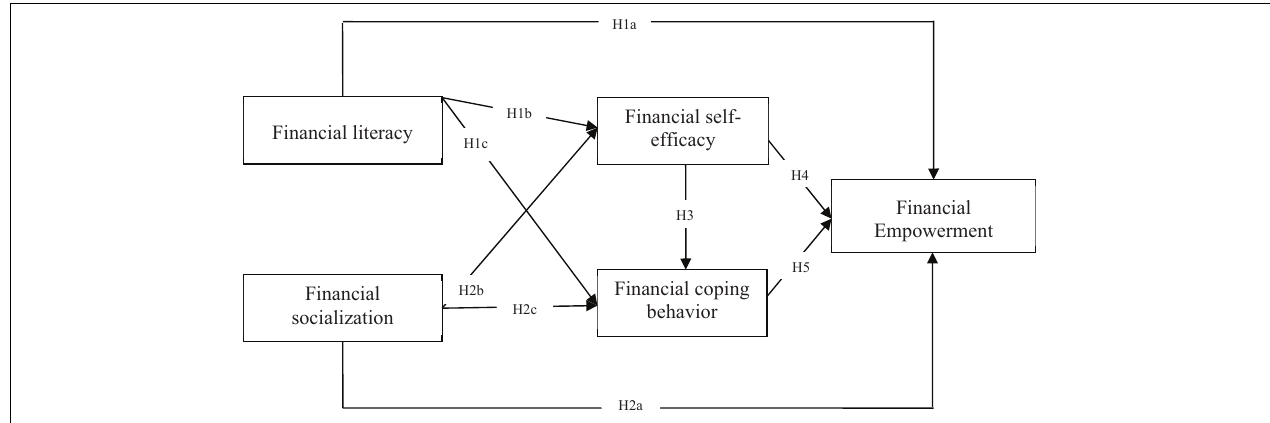
FIGURE 1 | Conceptual model. All arrows indicate hypothesized positive